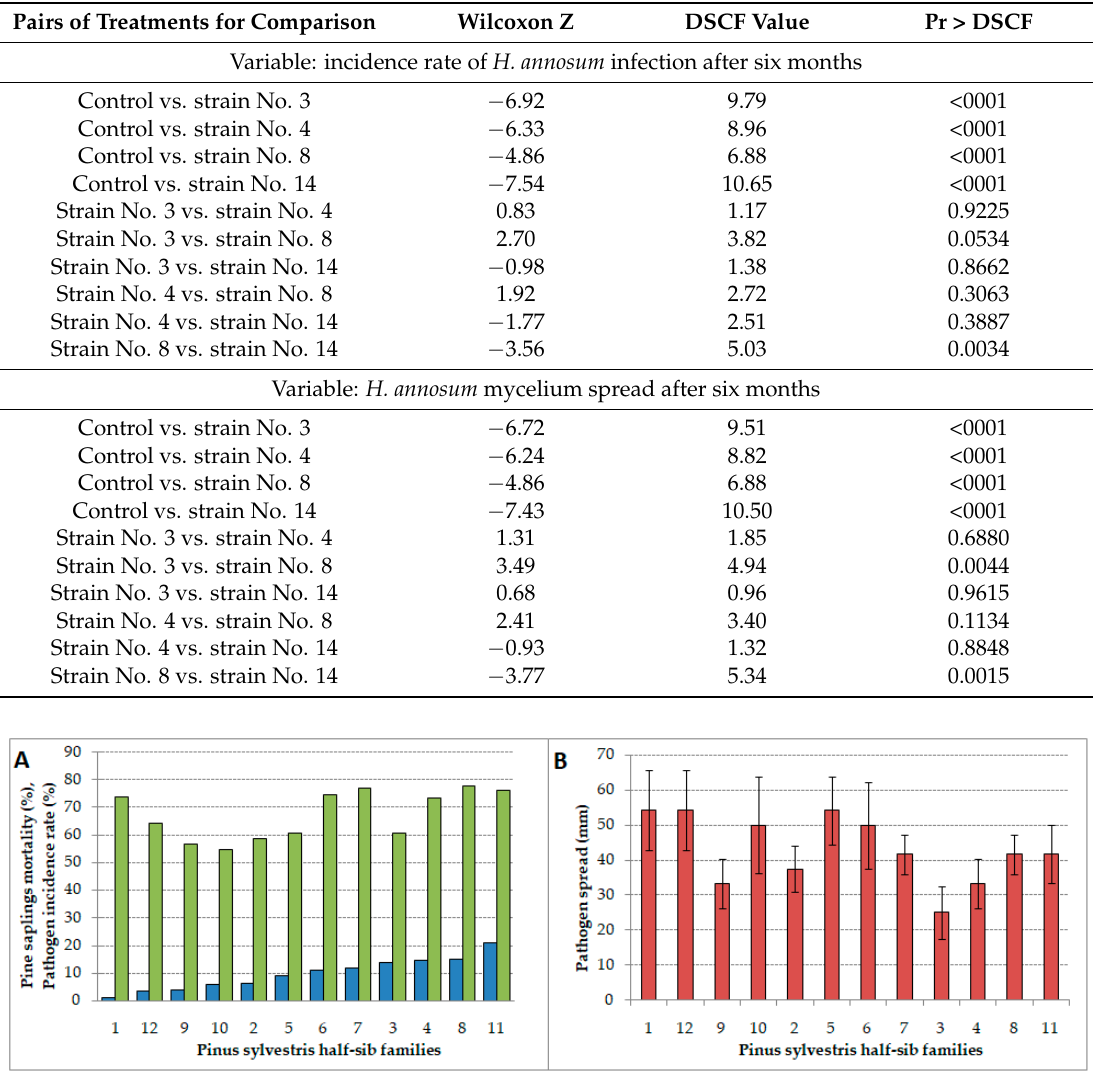
Figure 3. ( A ) Pine saplings mortality (%; blue bar), incidence rate (%; green bar) and ( B ) pathogen spread (mm), in 12 Scots pine half-sib families. Mortality (%) presented as total dead seedlings percentages 10 months after inoculation. Incidence rate (%) presented as average incidence rate 2, 6, and 10 months after inoculation. Pathogen spread (mm) presented as average pathogen spread 2, 6, and 10 months after inoculation (Standard errors are shown above the bars) .